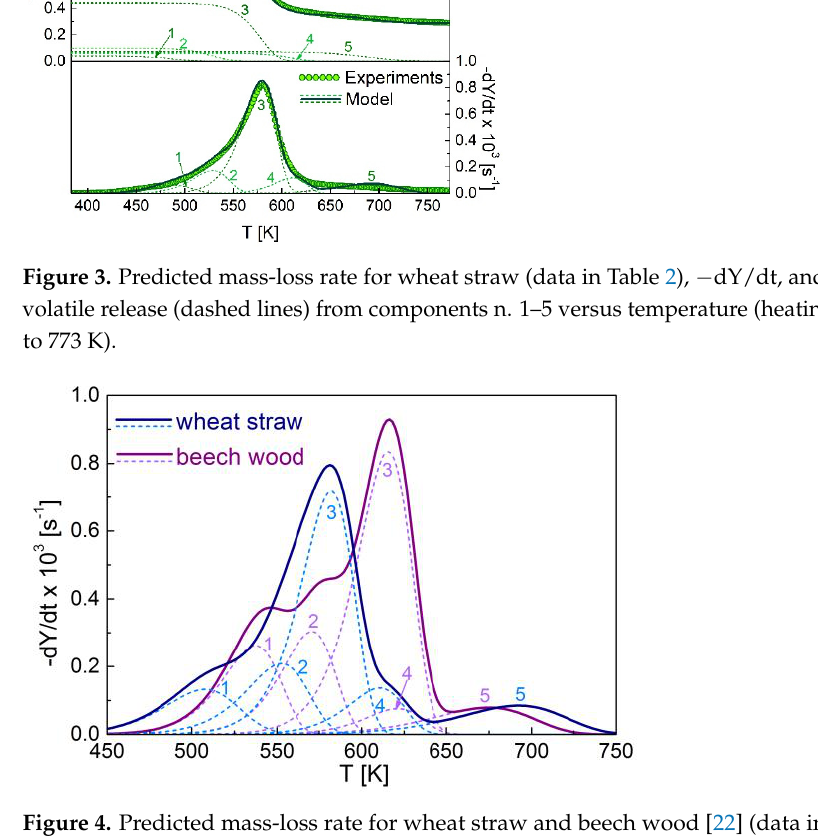
Figure 5. Predicted mass-loss rate for wheat straw (solid lines) and beech wood (dashed lines) [22] (data in Table 2A,B), − dY/dt from their pseudo-macrocomponents versus temperature (heating rate 5 K/min, up to 773 K). The activation energies are generally lower for the straw decomposition with respect to wood (values of 101 and 136 kJ/mol versus 139 and 170 kJ/mol for the overall decom- position of the low-temperature pseudo-macrocomponent, including extractives and hemicellulose), though the differences for the pseudo-cellulose decomposition are smaller (a value of about 180 with respect to 195 kJ/mol). These findings can be attributed to the activation of the straw reactions at lower temperatures, whereas the obvious differences in pre-exponential factors account for the different position in the peaks of the five com- ponent rates (values in the order of 507, 552, 580, 610, and 691 K for wheat straw versus 538, 571, 616, 621, and 675 for beech wood, given a heating rate of 5 K/min). From Figure 5 (heating rate 5 K/min), it appears that the temperature ranges of de- composition are approximately 420 – 600 K, 500 – 620 K, and 550 – 773 K (pseudo-macrocom- ponents hemicellulose with extractives, cellulose, and lignin in the order) for wheat straw versus the corresponding 470 – 610 K, 530 – 650 K, and 570 – 773 K for beech wood. For both samples, the pseudo-lignin decomposition takes place over a wide temperature range, which is also approximately the same. This result is in line with the same values of the estimated activation energies for the two components. In addition, as indicated by the largest differences in the corresponding activation energies, the differences between the two samples are significant for the low-temperature pseudo-macrocomponent. It can be hypothesized that the inclusion of a further component, maybe to only describe the de- composition of extractives, may reduce such differences. Finally, globally, the pseudo-